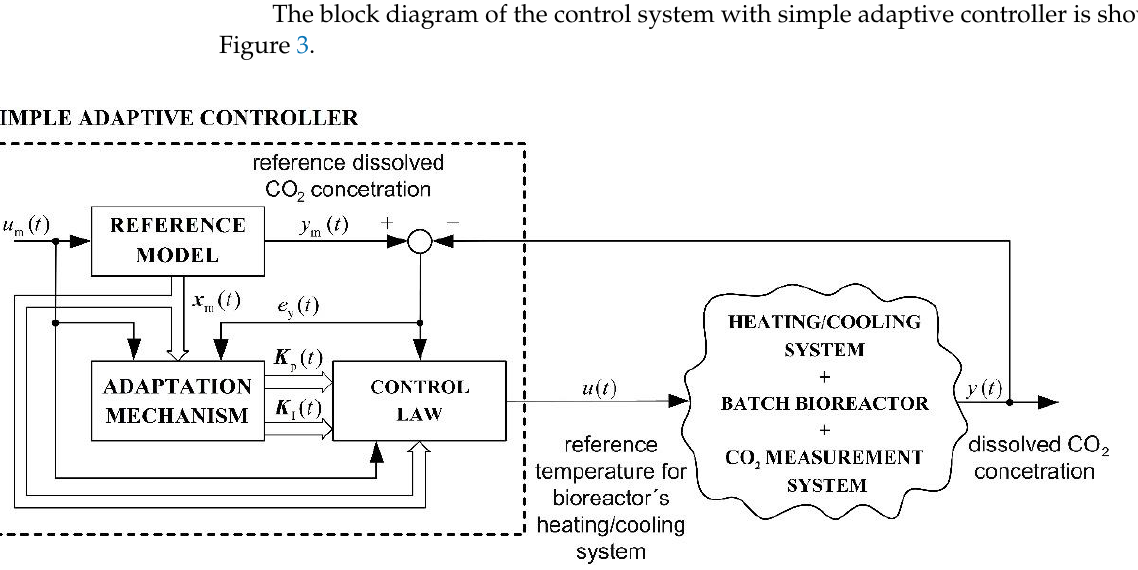
Figure 3. Block diagram of the control system with simple adaptive controller (MRAC-ASPR).